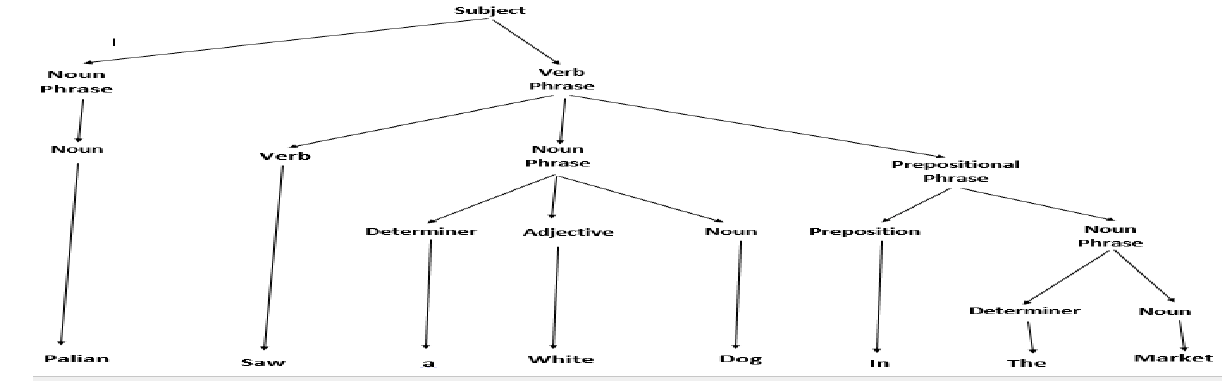
Figure 10. Semantic analysis.